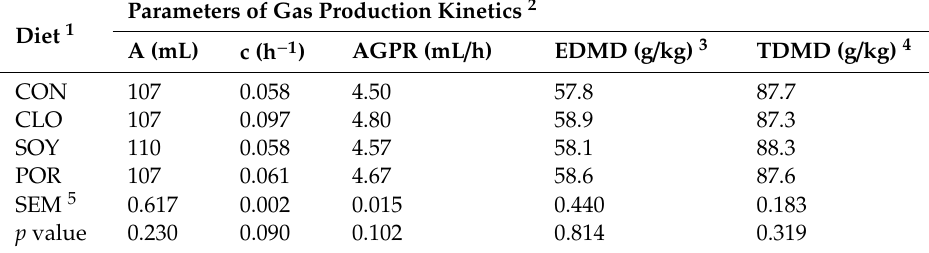
Table 5. Gas production kinetics (A, c and AGPR), e ff ective dry matter degradability (EDMD) and true dry matter digestibility (TDMD) after 72 h of incubation of the experimental diets in batch cultures inoculated with ruminal microorganisms from sheep.